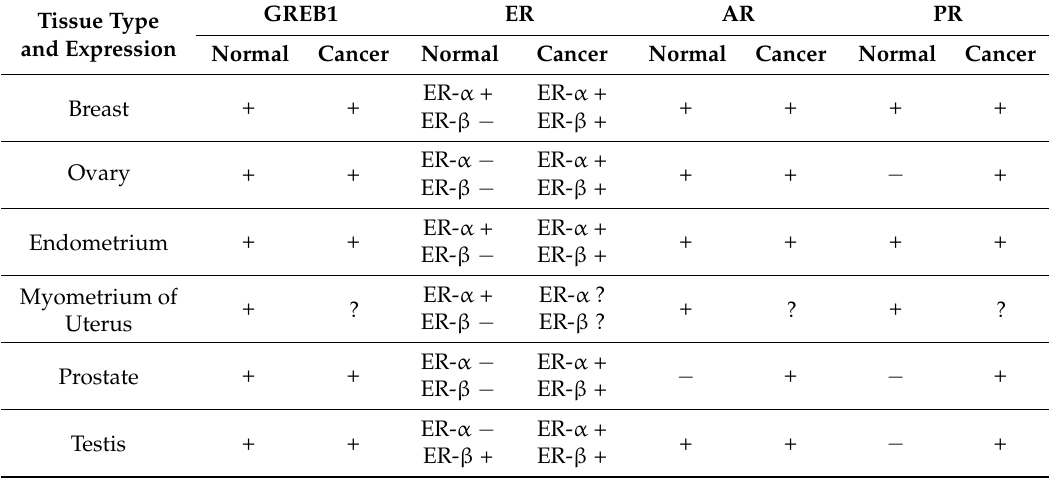
Table 1. The Protein Expression of GREB1 and Hormone Receptor in Different Tissue Types. ER: Estrogen Receptor, AR: Androgen Receptor, PR: Progesterone